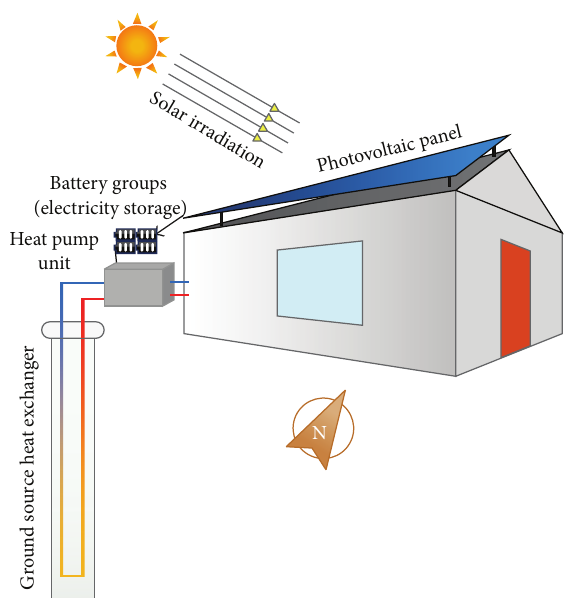
Figure1:SchematicviewofthesolarassistedGSHPairconditioning